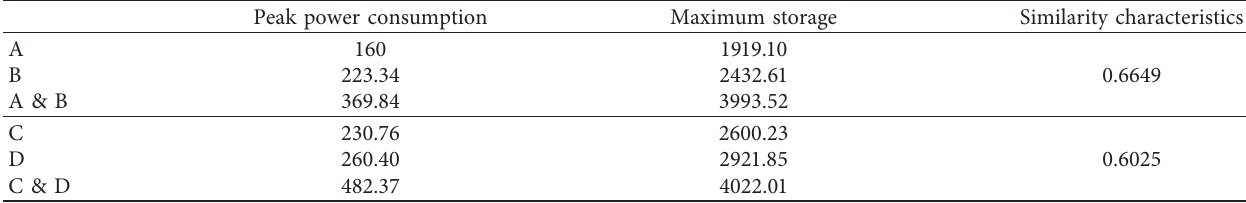
Table 2: Statistic of users and their combination.